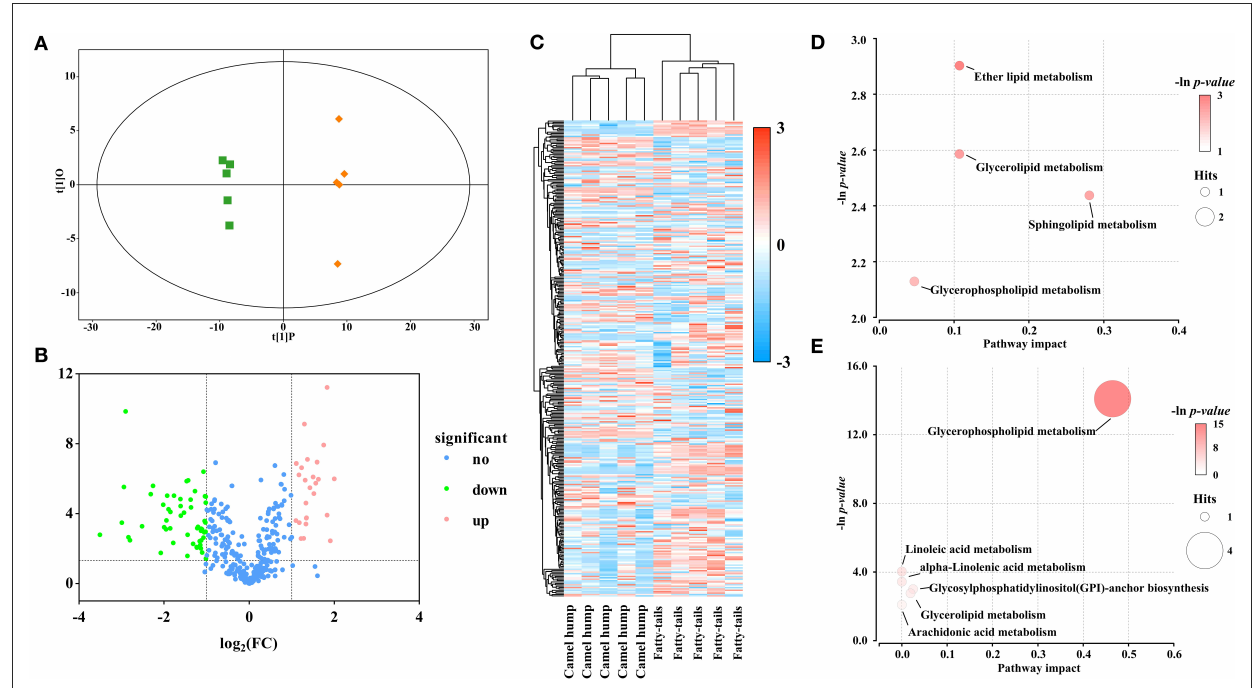
FIGURE5 Statistical analyses of lipids in camel hump vs. fatty-tails. (A) OPLS-DA scores plot. Green squares represent camel hump, yellow rhombus represent fatty-tails (R 2 Y = 0.995, Q 2 = 0.983). (B) Volcano plot using log 2 FC as the x-axis, -log 10 ( p < 0.05) as the y-axis; FC values were the ratios of lipid content in camel hump to that in fatty-tails. (C) Heat map and hierarchical clustering of differential abundance lipids between camel hump and fatty-tails. To build the heat map, normalized abundances were used; the red color represents high abundance, whereas the blue color represents low abundance. Bubble plots of KEGG pathway analysis in positive (D) and negative (E) ionization mode, and the supplementary data showed in Supplementary material